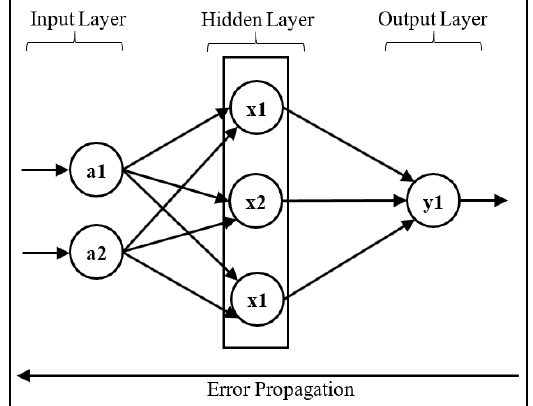
Figure 3. A three-layer feed-forward back-propagation neural network (Source: after Jain and Ormsbee, 2002) Back-propagation neural network is the most commonly used model structure Figure 3. The circles represent neurons and lines represent connections; a layer consists of a group of neurons with similar characteristics. Here, Figure 3 consists of a two-neuron input layer, three-neuron hidden layer and a single- neuron output layer. The input given is propagated in the forward direction and using a nonlinear function output is calculated. This step is followed by computation of error at the output layer, back-propagation of the error through the network and updation of the weights using a nonlinear optimisation function. This whole process of neural network training is repeated to minimize the error and the well-trained neural network model is then used for prediction (Jain and Ormsbee, 2002; Tseng et al., 2002; Zhang, 2003; Ghiassia et al., 2005; Zhang and Qi,